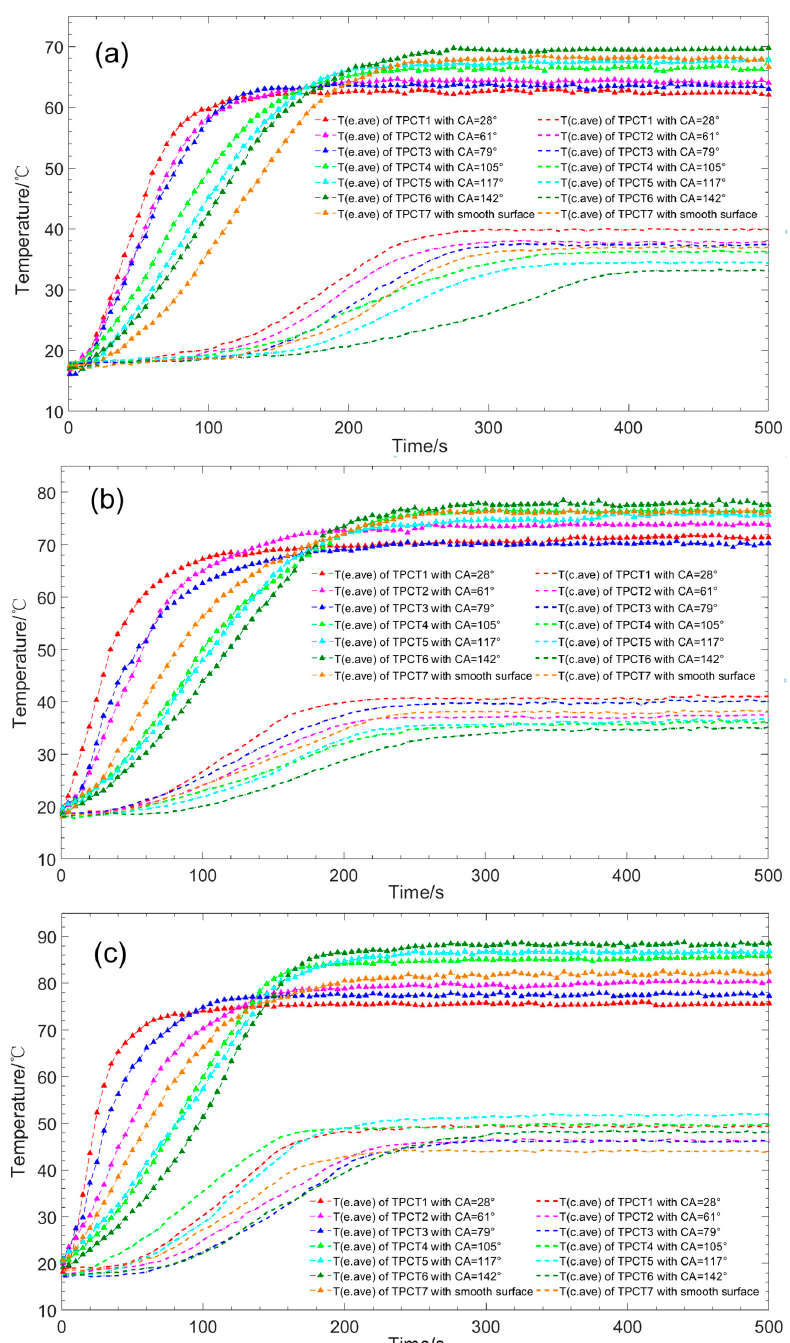
Figure 6. Start-up performances of TPCT1–TPCT7 at di ff erent input powers: ( a ) Q in = 40 W; ( b ) Q in = 60 W; ( c ) Q in = 80